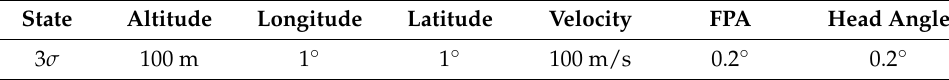
Figure 26. Velocity histories of the bank angle.